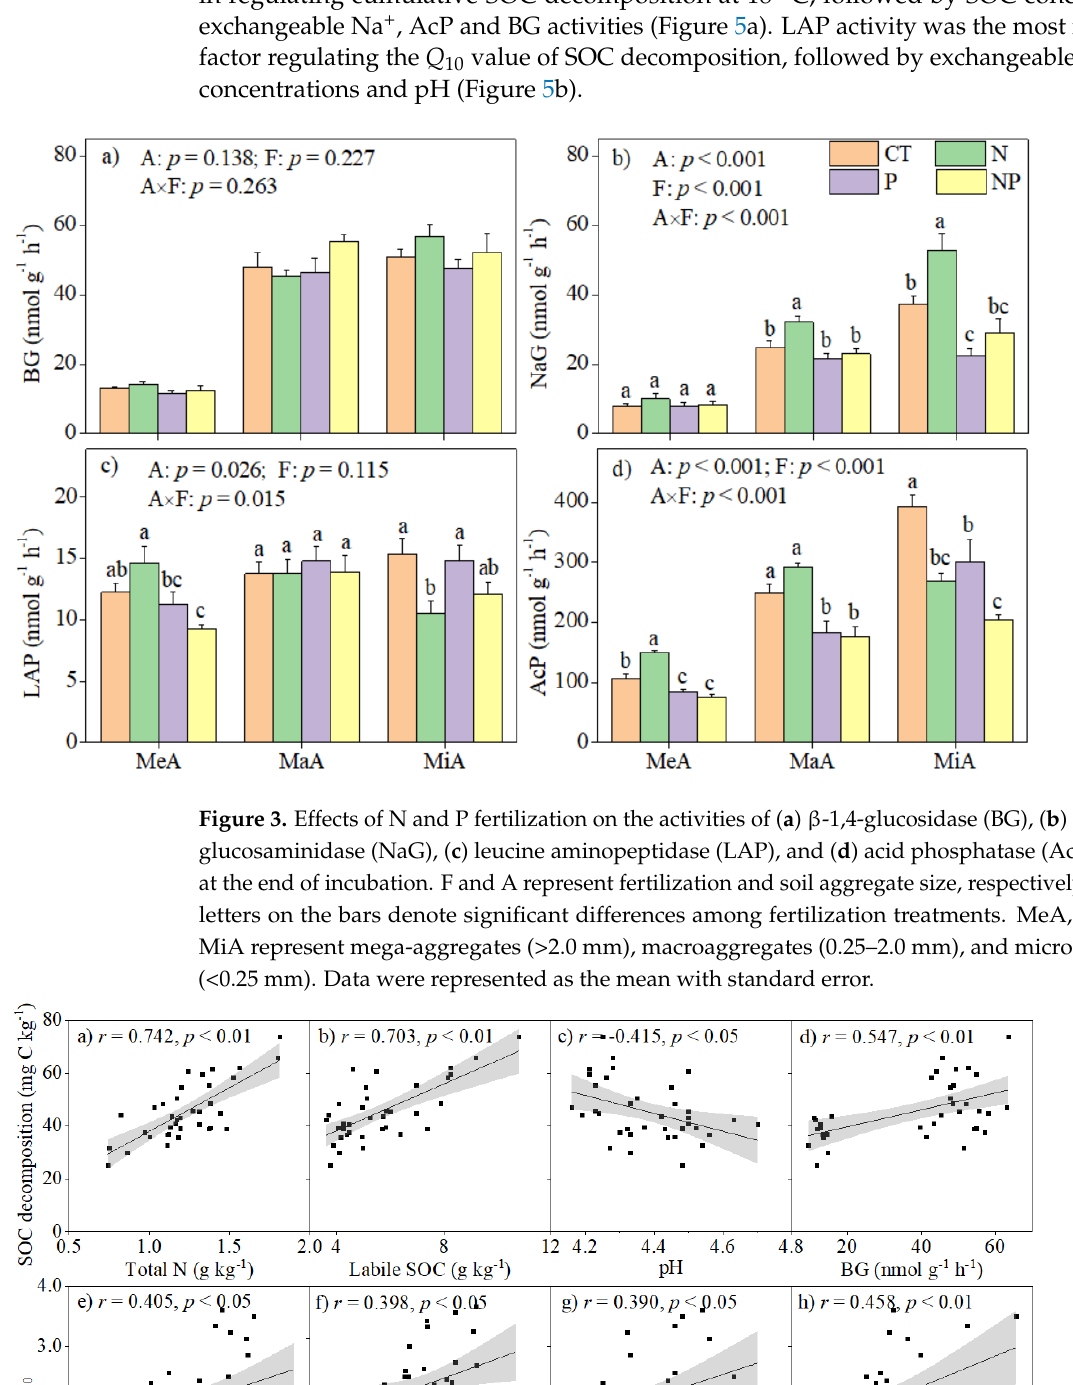
Figure 4. Pearson’s correlation coefficients of key soil chemical properties and enzyme activities with ( a – d ) cumulative soil organic carbon (SOC) decomposition and ( e – h ) temperature sensitivity ( Q 10 ). BG and LAP represent β –1,4–glucosidase and leucine aminopeptidase, respectively. The shaded area represents 95% confidence interval.